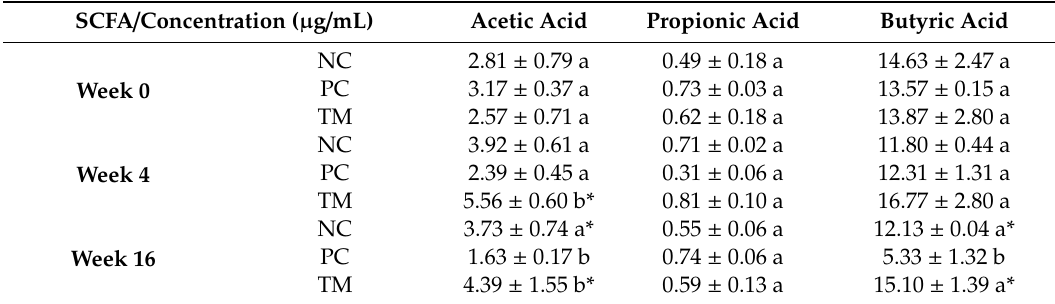
Table 2. Concentrations of acetic, propionic, and butyric acids in fecal samples from the IMD-treated mouse